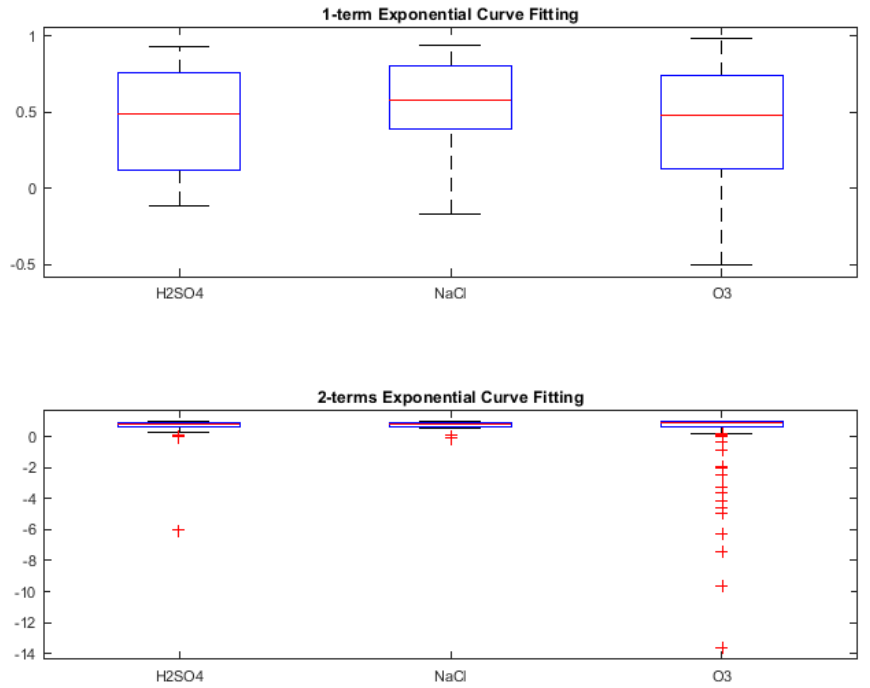
Figure 8. R-squared values for Exponential curve fitting.